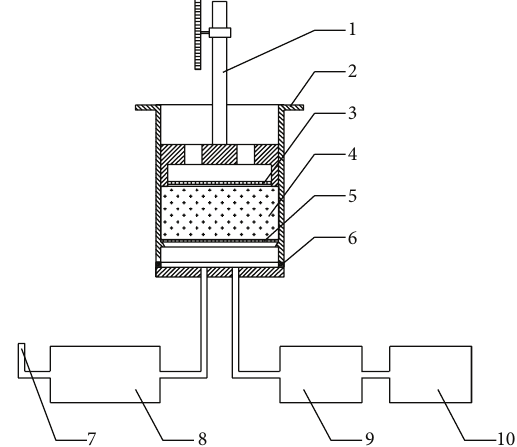
Figure 1: Measurement equipment in cross section by DC method. 1: piston with thickness indicator. 2: measure specimen cylinder barrel. 3: grid or perforation plate. 4: specimen. 5: grid or perforation plate for supporting the specimen. 6: seal ring. 7: opening to the atmosphere. 8: differential pressure measuring equipment. 9: flow meter. 10: air supply.